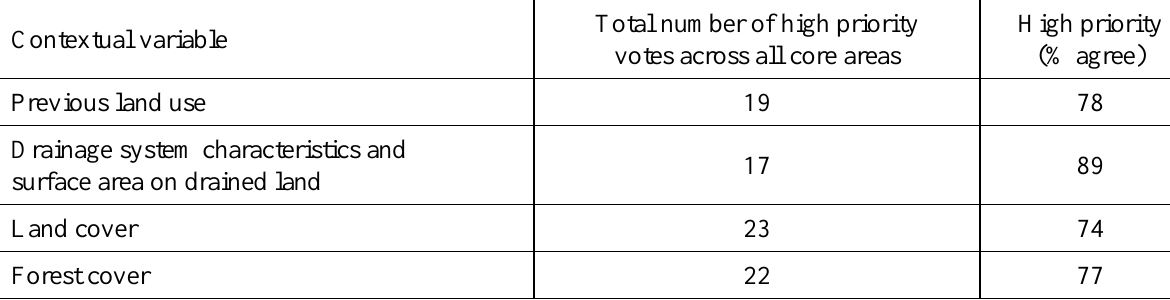
Table 1. Contextual variables agreed by >70 % of respondents as being important to measure and report alongside all core domain sets (Figures 7–10) for tropical peatlands. Note that although all respondents were asked to vote on every variable, they were advised not to vote on variables they were unsure about, so the total number of votes received differed slightly between